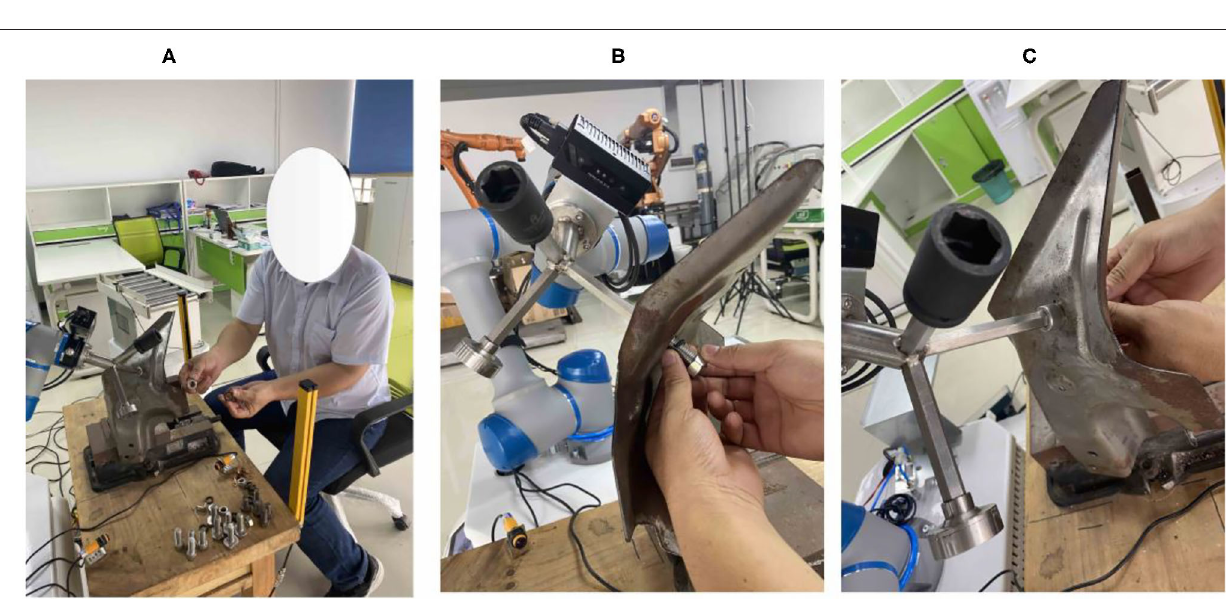
FIGURE 17 | Detailed process of human–robot cooperative assembly. (A) Indicates that adaptation tools are selected. (B) Represents assembly. (C) Stands for induced